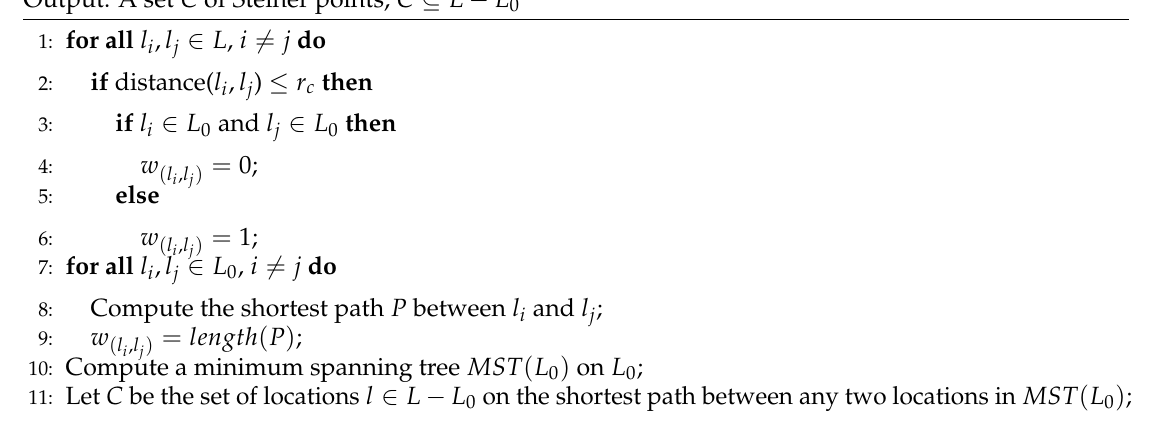
Algorithm 3 Approximation Algorithm for